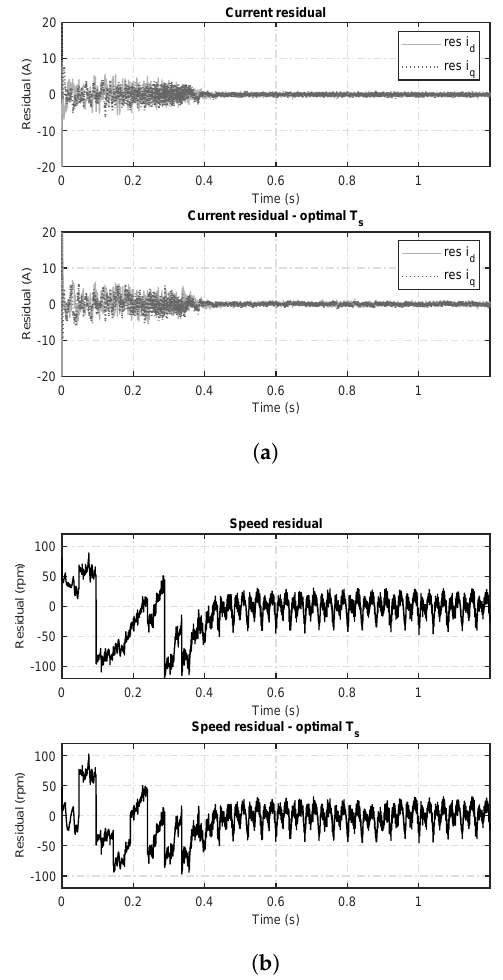
Figure 5. ( a ) Current residuals with original and optimal sampling time estimation; ( b ) Speed residuals with original and optimal sampling time